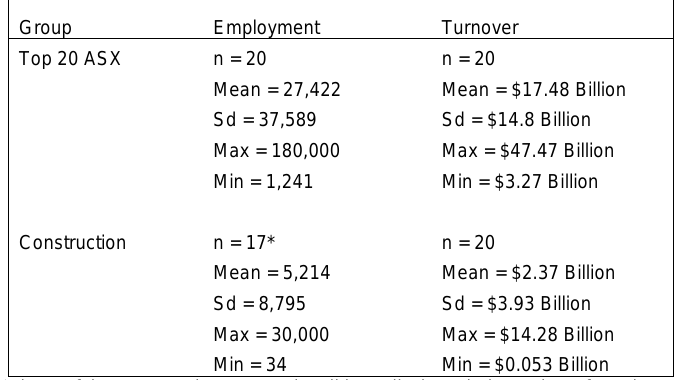
Table 5: Summary of sizes of the two sample